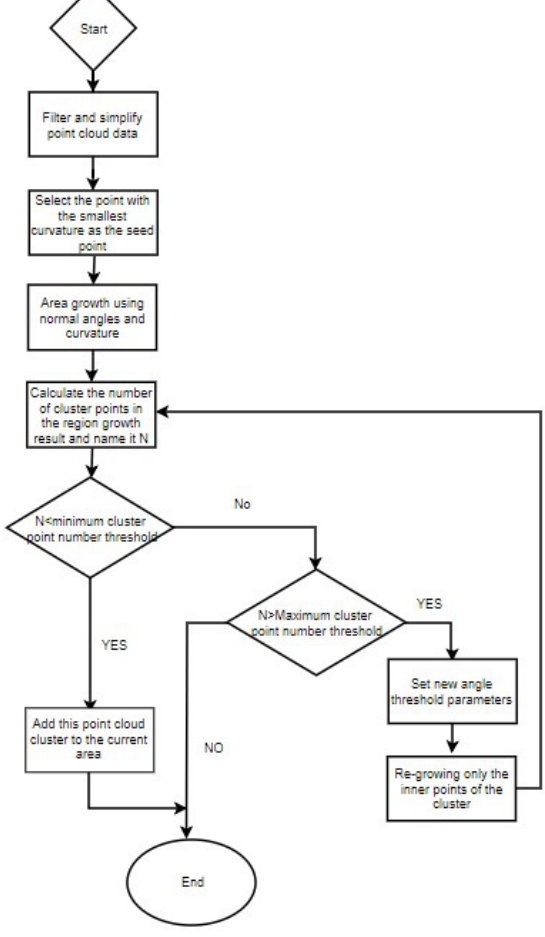
Figure 2. Flowchart based on improved region growing